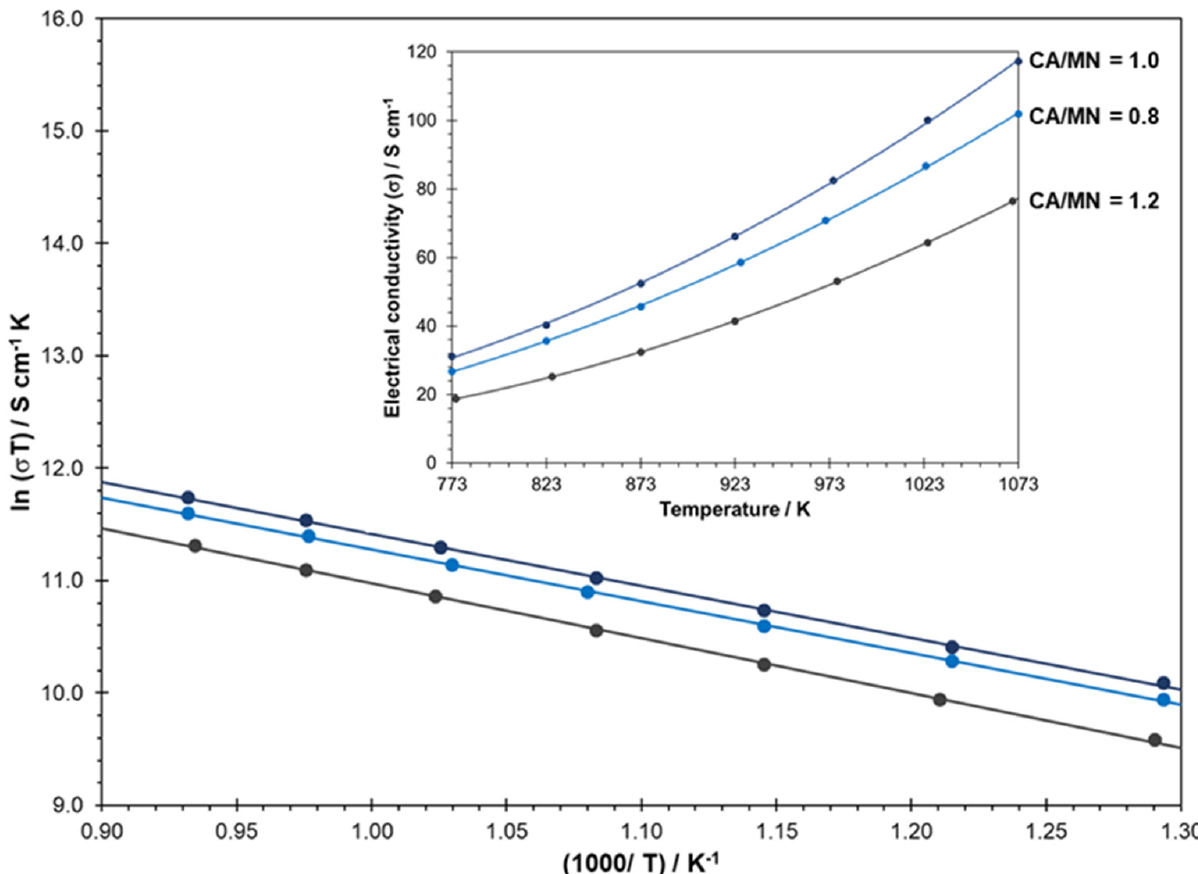
Figure 8. Arrhenius plot and temperature-dependent electrical conductivity (insert) of CMC spinel synthesized at different CA/MN ratios.